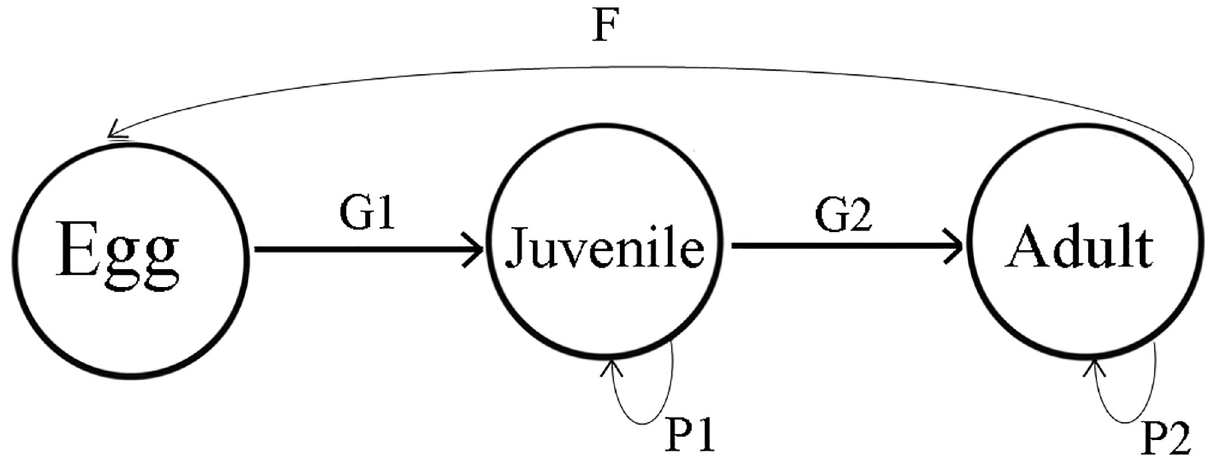
Fig 1. Conceptual diagram of population dynamics of freshwater turtles used for construction of a stage structure matrix model to estimate capacity for sustainable harvest in freshwater turtles.